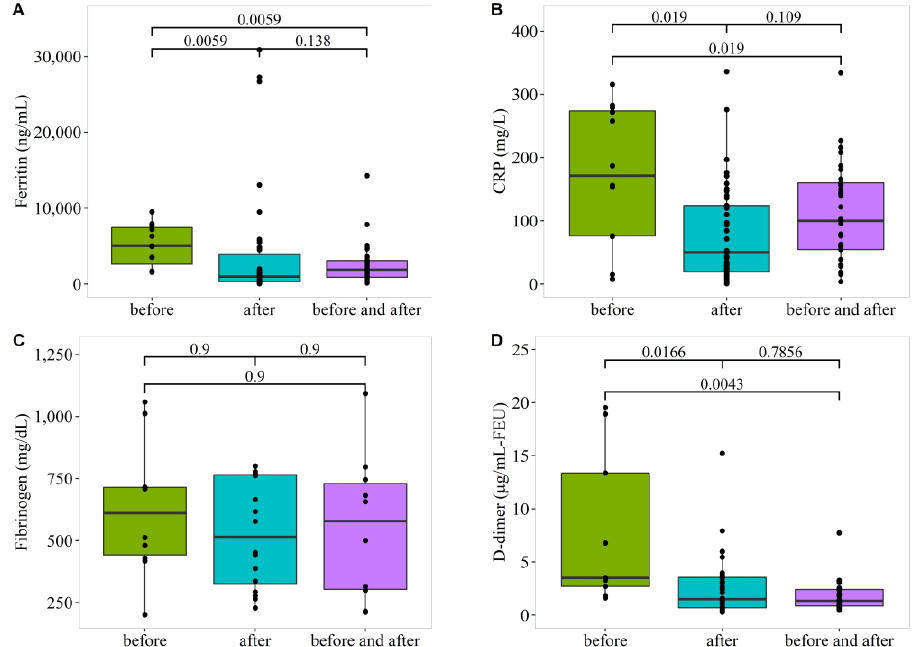
Figure 3. Effect of dexamethasone healthcare treatment plans on laboratory test results. Boxplots of laboratory test results for Dexamethasone healthcare treatment plans. ( A ) Ferritin (ng/mL), ( B ) CRP (mg/L), ( C ) Fibrinogen (mg/dl), and ( D ) D-dimer ( µ g/ml-FEU). Patients treated with Dexamethasone before COVID-19 infection (DxB). Patients treated with Dexamethasone after COVID-19 infection (DxA). Patients treated with Dexamethasone before COVID-19 infection and continued their treatment after diagnosis (DxBA). Kruskal-Wallis test was used to test the differences in the distributions in laboratory readings between the different Dexamethasone treatment regimens, and pairwise comparisons were corrected for multiple testing with Benjamini – Hochberg method.